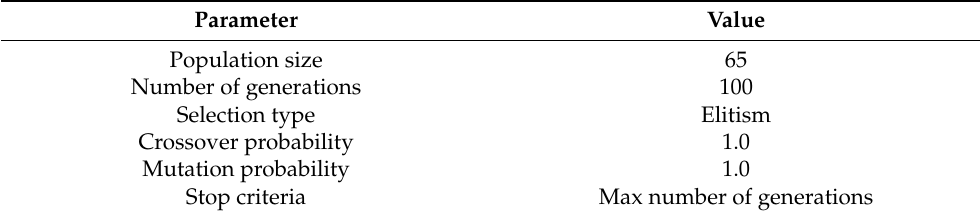
Table 2. Tuning of the genetic